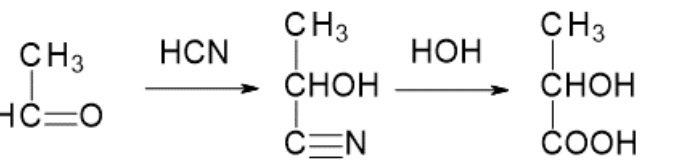
Figure 2. Scheme presenting the method of producing LA from acetic aldehyde using hydrogen cyanide [5].